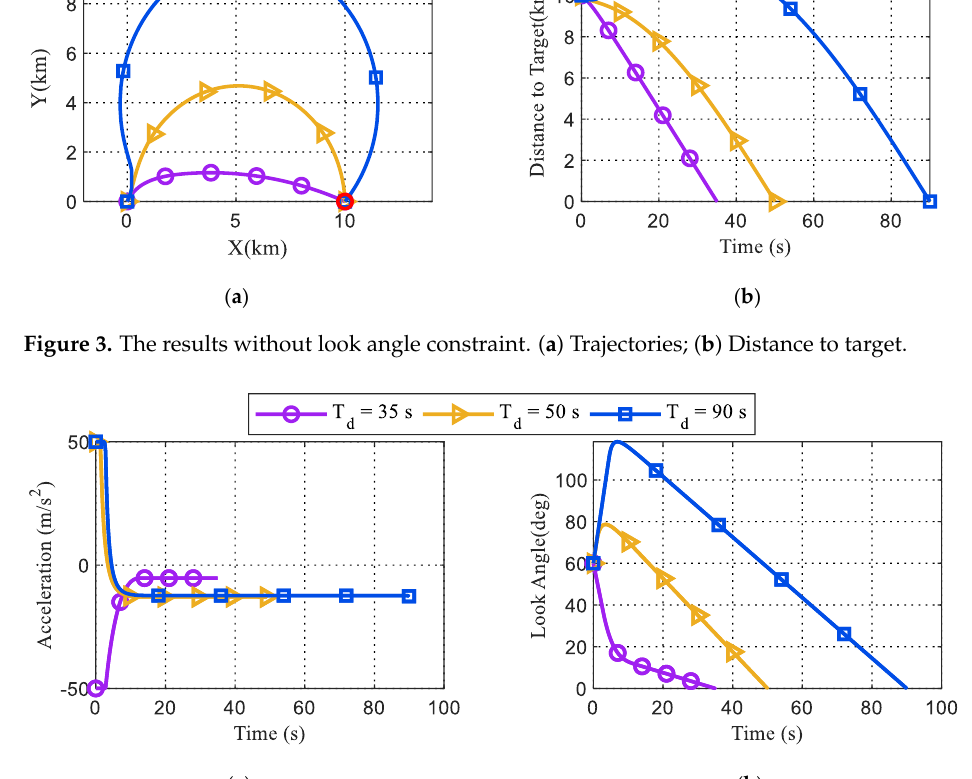
Figure 4. The results without look angle constraint. ( a ) Lateral acceleration; ( b ) Look angle.